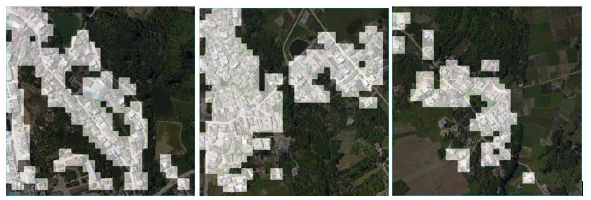
Figure 8. The candidate foregrounds